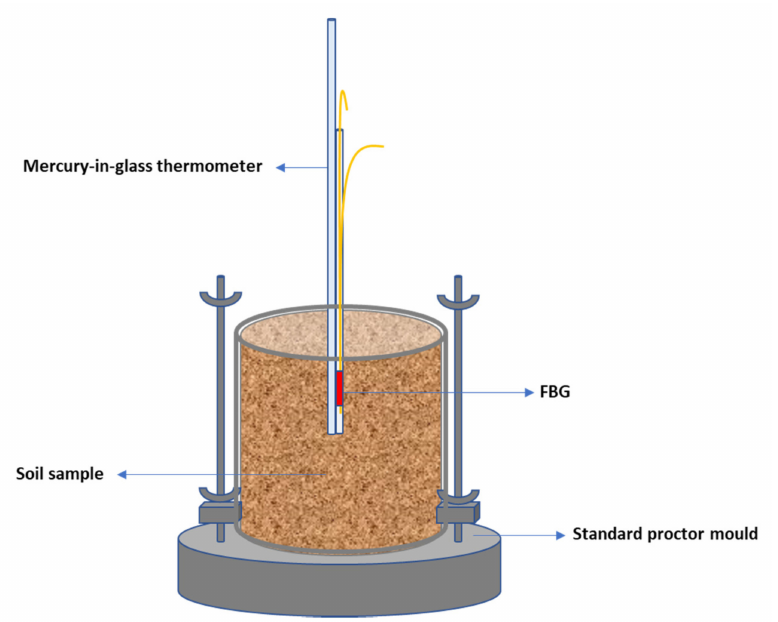
Figure 9. The arrangement of the experiment to monitor the salinity concentration in the